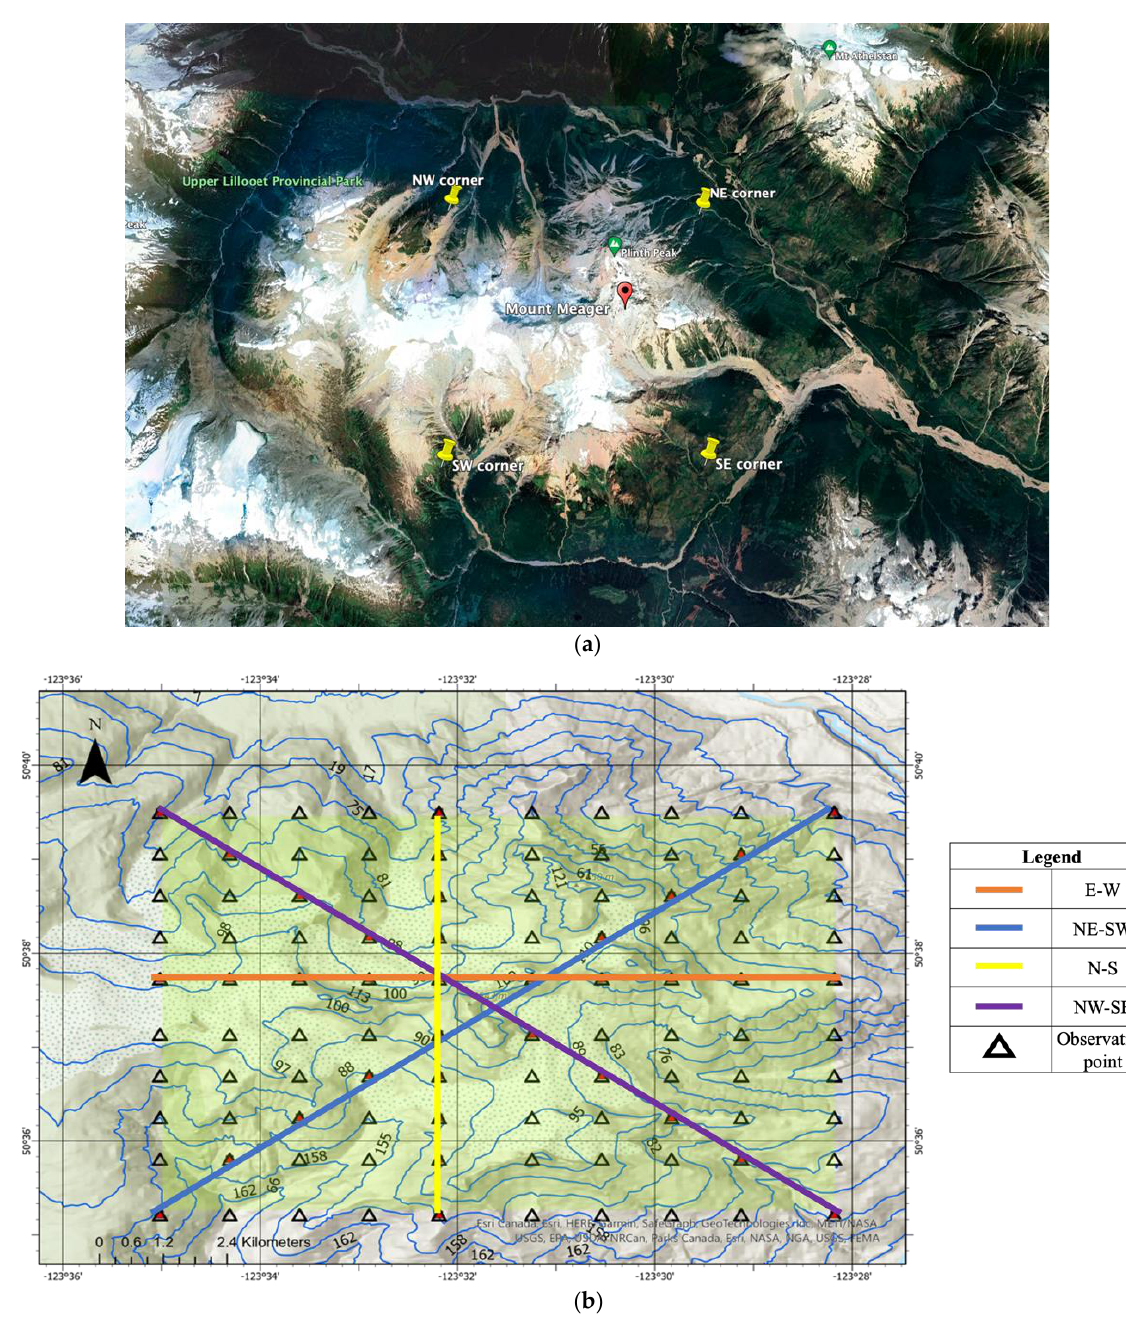
Figure 5. Map of Mount Meager area showing ( a ) a Google Earth Satellite image with the four corner markers of the DD plane for the modelling; ( b ) elevation contour map of the region with DD plane highlighted in green. The locations of cross sections are indicated with different colors.